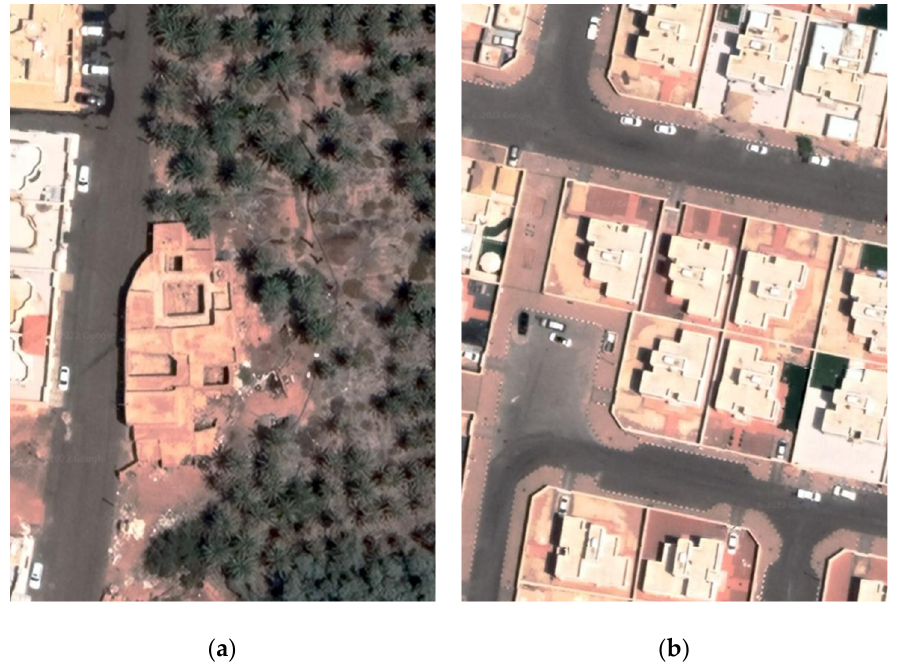
Figure 13. ( a ) top view for Case 2; and ( b ) top view for Case 3. An hourly comparison of the temperatures at the two locations between August 1 and 5 September during the measurement period (Table 5) indicates that the maximum temperature for Case 3, was registered as 44.4 degrees Celsius at 15:00 on 4 August com- pared to 40.6 degrees Celsius for Case 3 during the same time period. In the same meas- urement period (06:00 on 15 August), the lowest temperature measured was 22.2 °C for Case 3 and 29 °C for Case 2. Table 5. Weather data analysis for two locations in Hail city. Case 2 Temp